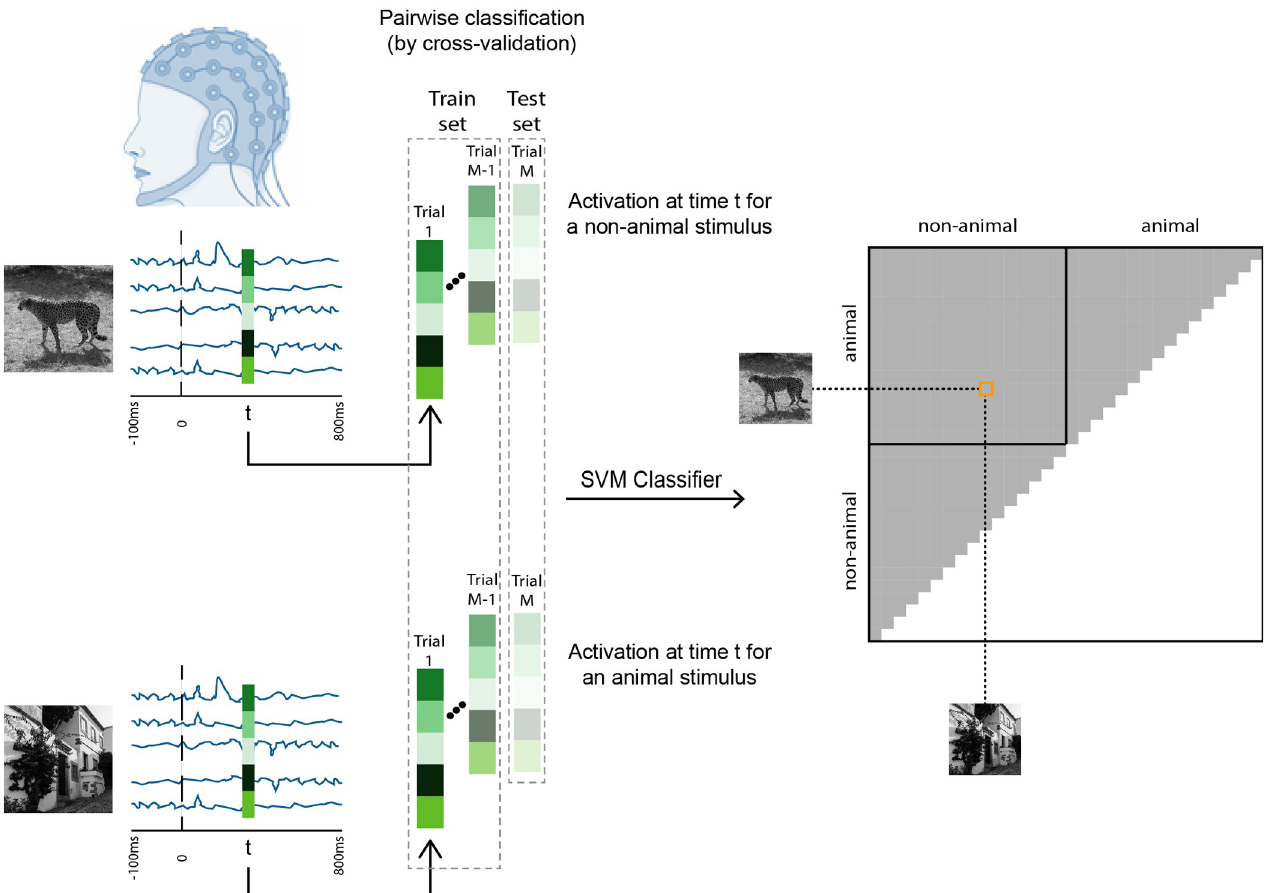
Fig 3. Representational dissimilarity matrices (RDMs). We trained an SVM to discriminate pairs of stimuli using their EEG responses at time-point t. This pairwise classification of stimuli by cross-validation SVM model leads to a 32 × 32 RDM at each time-point t.